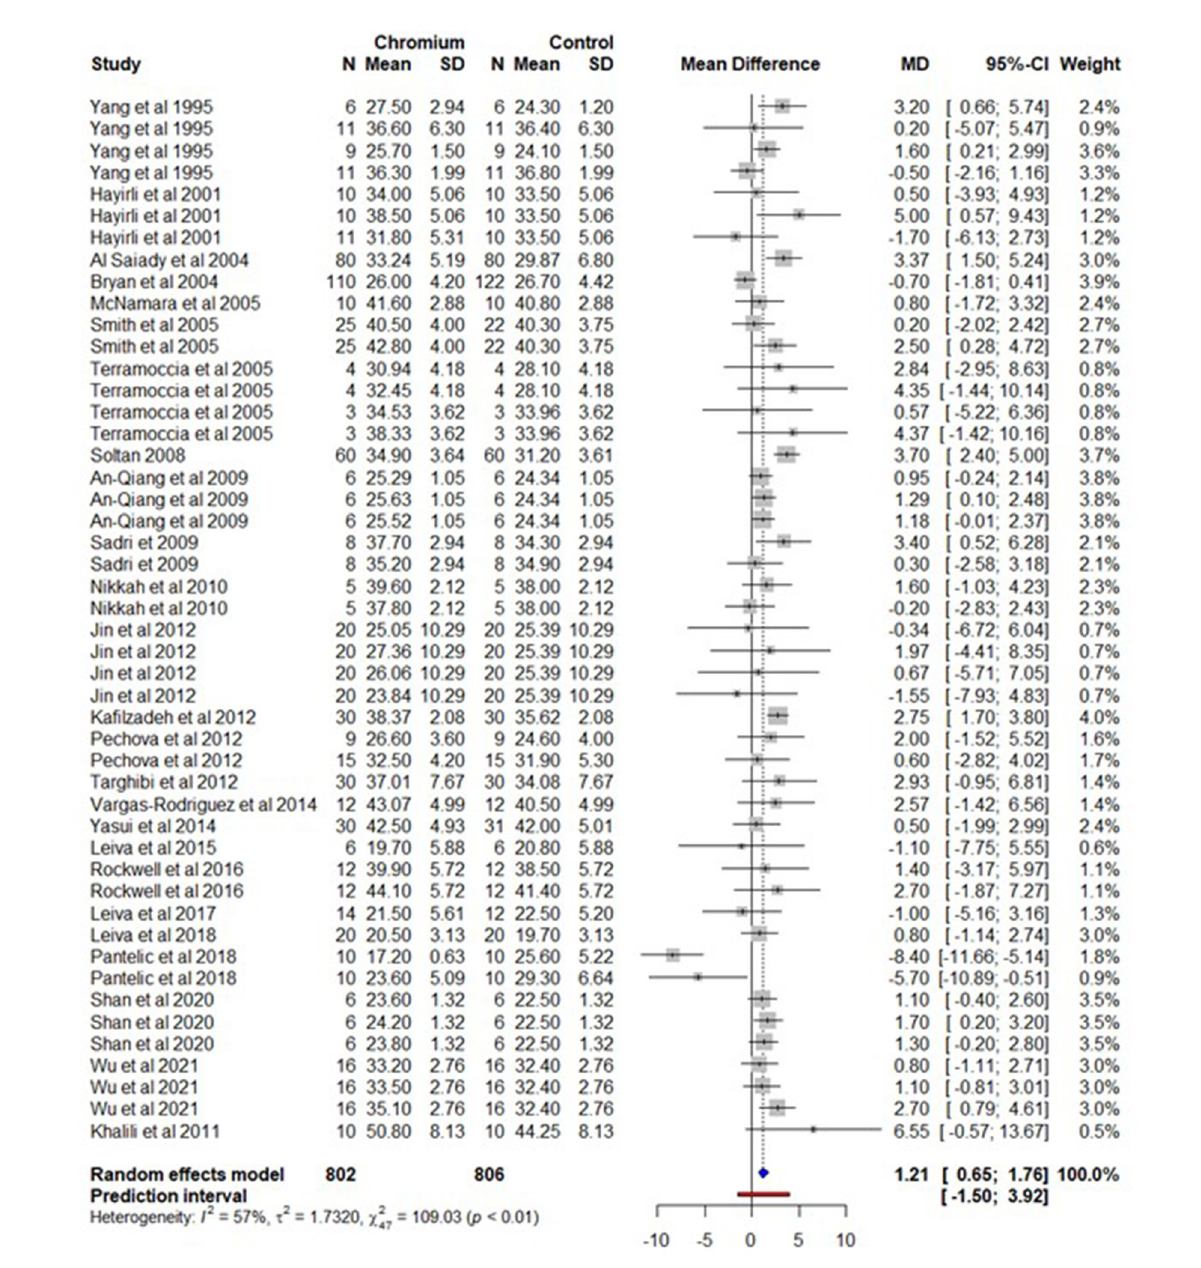
FIGURE3 The forest plot of the random-effect meta-analysis for milk production. The effect size was calculated as the mean difference (MD) and the solid vertical line represents the line of no effect or zero line. The dotted vertical line represents the average effect size for milk production in cows supplemented with chromium and the negative value under the MD heading indicates a decrease in milk production and vice versa. The black horizontal line represents the confidence interval for each study and the gray square represents weight or effect size of the corresponding study. The blue diamond represents the average effect size of the